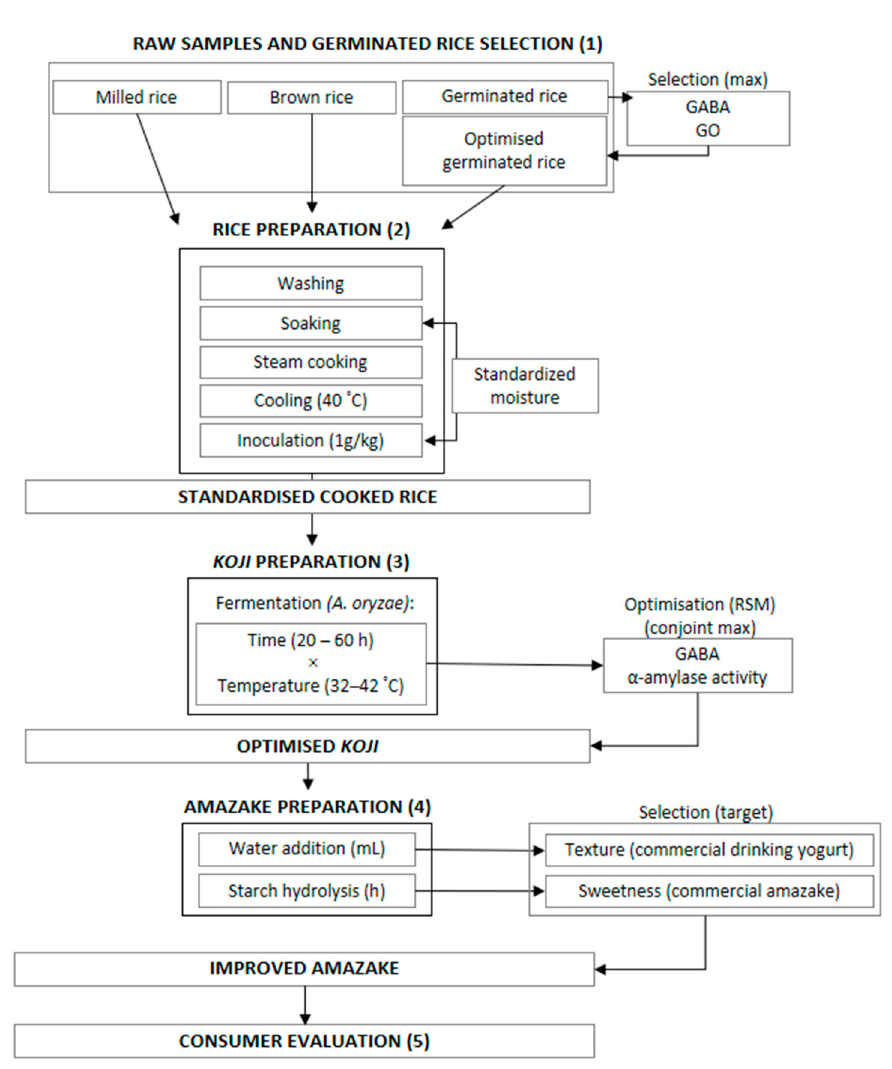
Figure 1. Schematic view of the experimental methodology, with numbers representing materials and methods, as well as discussion sections (e.g., 1 represents Sections 2.1 and 3.1). The three raw samples were further soaked, cooked and inoculated with A. oryzae to produce Koji . The GABA content and α -amylase activity were analysed in the Koji preparation process to optimise the best inoculation time and